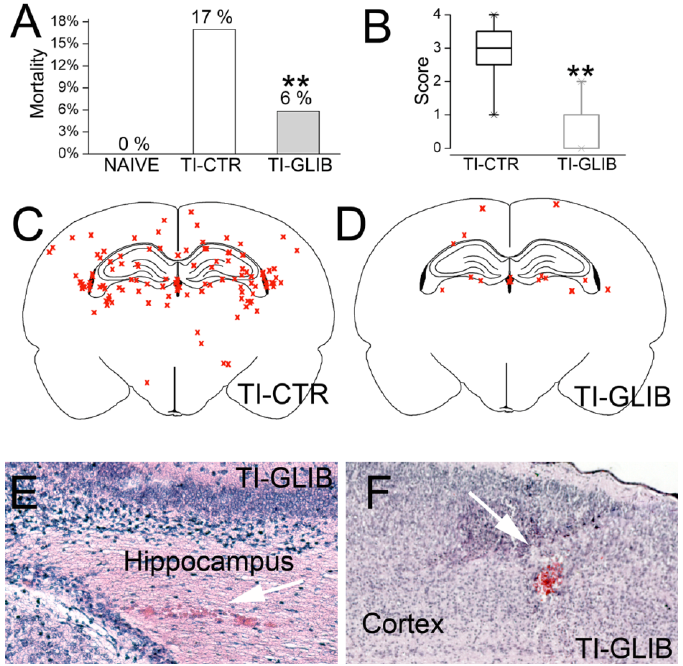
Figure 5. Prenatal low dose glibenclamide infusion reduces mortality, and the incidence and severity of periventricular hemorrhages following tandem insults (TI). ( A ) mortality at 30 h in pups subjected to no injury (naïve), or in pups subjected to TI whose mother was administered no treatment or vehicle treatment (TI-CTR), or in pups subjected to TI whose mother was administered low dose glibenclamide infusion after IUI (TI-GLIB); data from 28 naïve, 72 TI-CTR and 84 TI-GLIB pups, respectively; ** p < 0.01. ( B ) hemorrhage scores (see Methods for definitions) at 30 h in TI-CTR pups ( n = 16) and TI-GLIB pups ( n = 14); box plot symbols as in Figure 4; note medians are 3 vs. 1 for TI-CTR vs. TI-GLIB, respectively; ** p < 0.01. ( C , D ) Distribution of hemorrhages at 30 h in TI-CTR pups ( n = 16) ( C ) and TI-GLIB pups ( n = 14) ( D ). ( E , F ) H & E-stained sections of brains from two TI-GLIB pups 24 h after TI showing small hemorrhages (arrows) involving white matter near the hippocampus ( E ) and the cortex ( F ); the images shown are representative of data from 10 brains from TI-GLIB